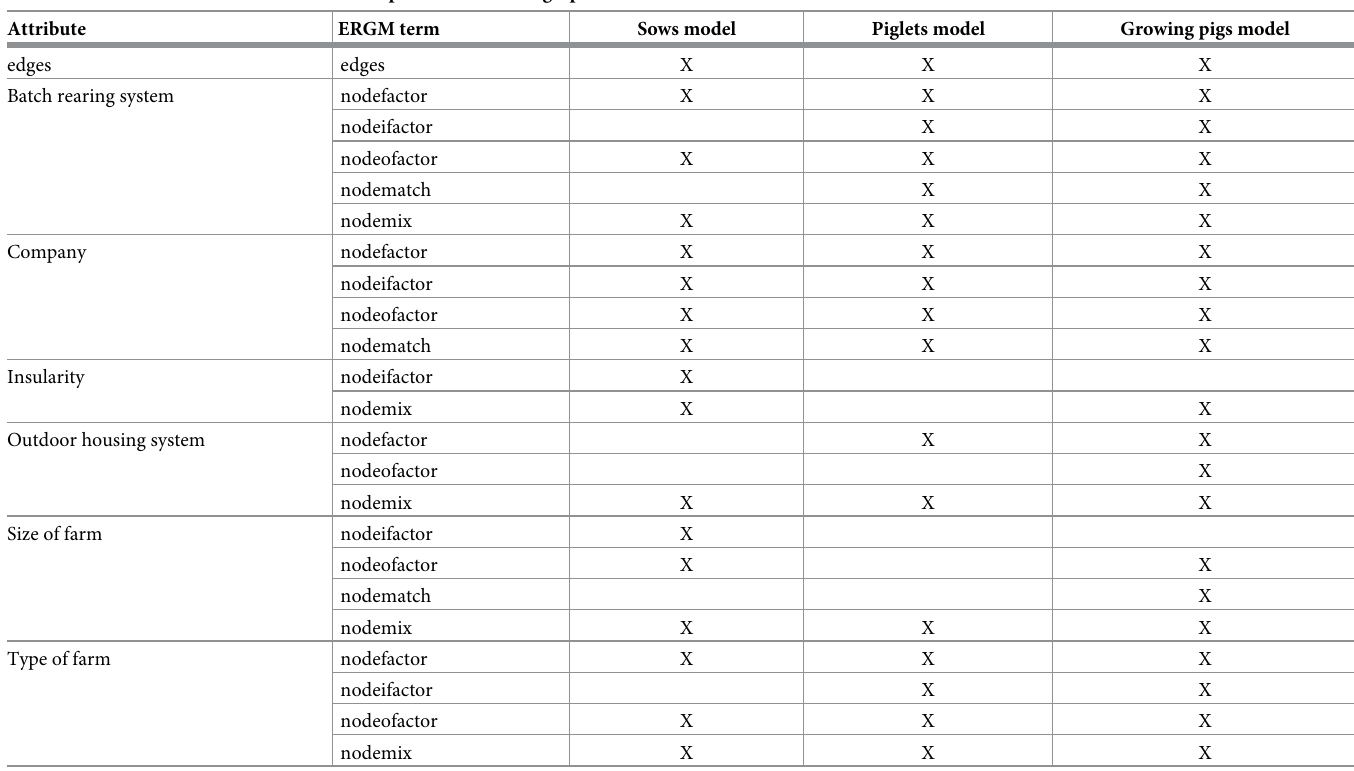
Table 7. Network statistics selected for each exponential random graph